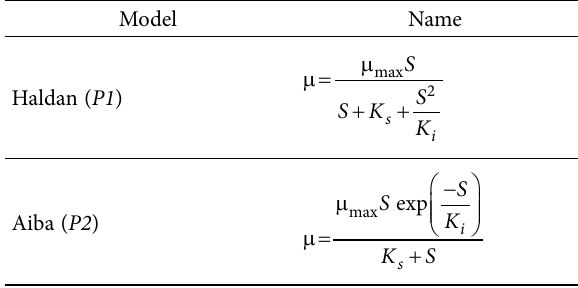
Table 3. Microbial specific growth rate constant models Model